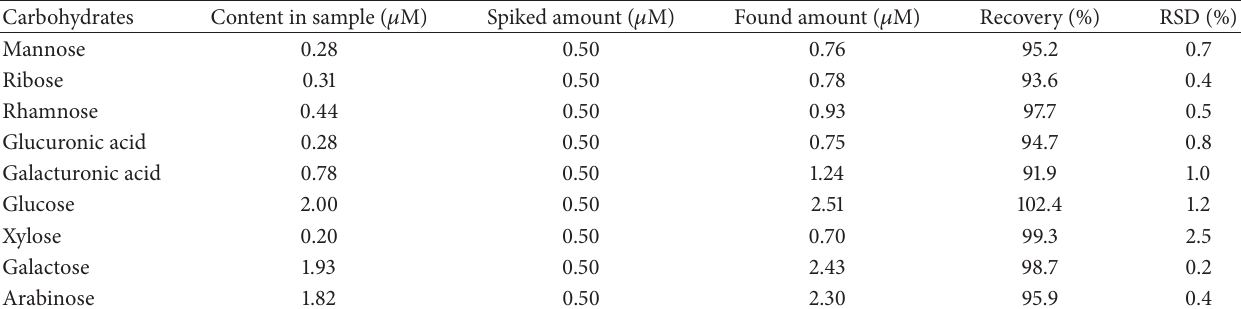
Table 3: Determination of the component monosaccharides in Yingshuang green tea TPS and recovery analysis ( 𝑛 = 3 ).